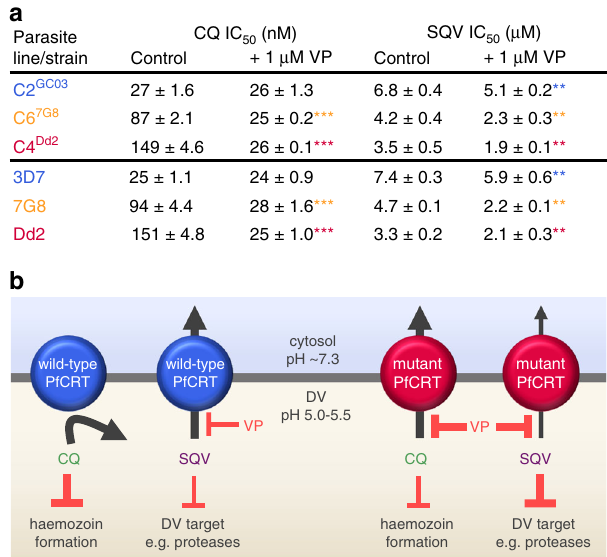
Fig. 6 CQ-resistance-conferring isoforms of PfCRT increase parasite susceptibility to saquinavir. a The antiplasmodial activities of CQ and saquinavir (SQV) against CQ-sensitive (C2 GC03 and 3D7) and CQ- resistant (C6 7G8 , C4 Dd2 , 7G8 and Dd2) parasites in the presence or absence of verapamil (VP). The data are the mean of n = 5 independent experiments (each yielding similar results) and the error is the SEM. The asterisks denote a signi fi cant difference from the relevant control (red asterisks, C4 Dd2 or Dd2 control; orange asterisks, C6 7G8 or 7G8 control; blue asterisks, C2 GC03 or 3D7 control); ** P < 0.01, *** P < 0.001, ns: non- signi fi cant (one-way ANOVA). The source datasets are provided as a Source Data fi le. b Mechanistic model for the increased susceptibility of CQ-resistant parasites to SQV. PfCRT 3D7 (wild-type PfCRT) lacks detectable CQ transport activity, whereas the CQ-resistance-conferring isoforms of PfCRT (mutant PfCRT) ef fl ux CQ from the DV. VP inhibits CQ transport via the mutant transporters, thereby re-sensitising the CQ- resistant parasites to this antimalarial drug. By contrast, PfCRT 3D7 has a greater capacity for transporting SQV out of the DV than do the mutant isoforms. Moreover, it is the wild-type protein that confers reduced sensitivity to SQV. Given that VP (1) inhibits SQV transport via both the wild-type and mutant PfCRT transporters and (2) increases the antiplasmodial activity of SQV in all of the parasite types, our fi ndings indicate that SQV acts on a target within the